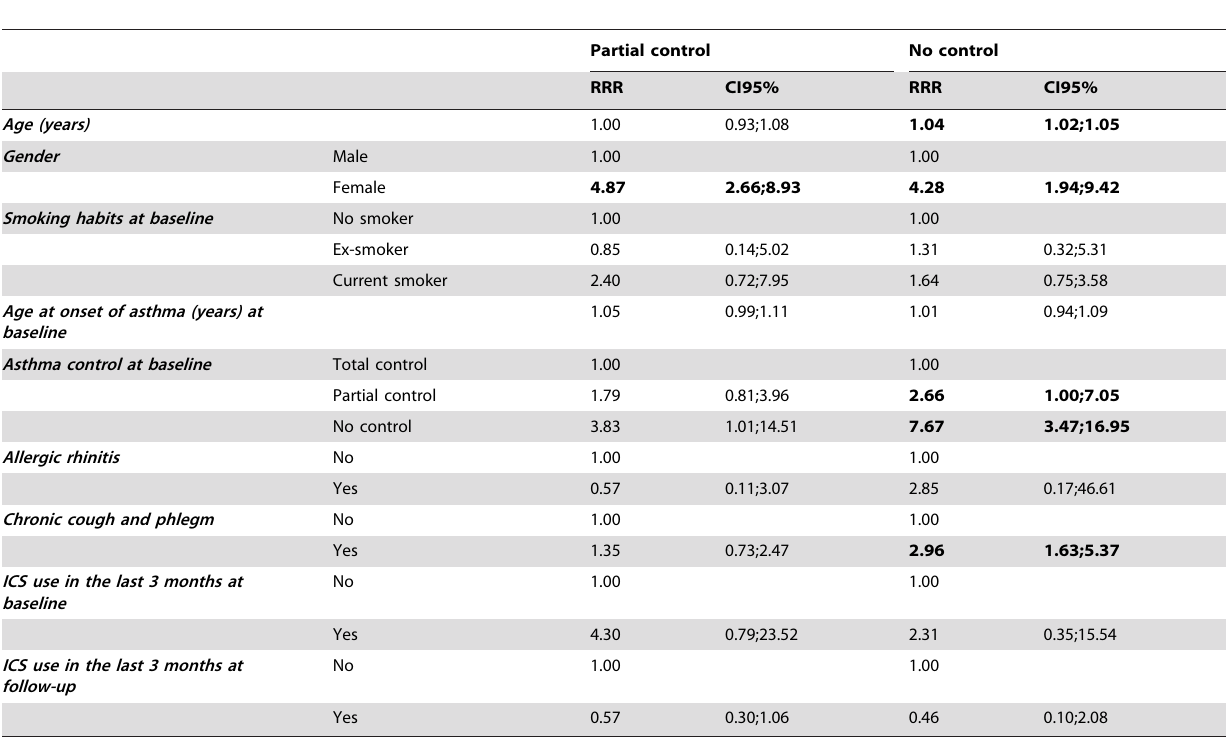
Table 4. Adjusted RRRs * (CI95%) for the effects of several variables reported at baseline or at follow-up on asthma control (partial control or no control) at follow-up, in subjects with non remittent asthma (n=127).